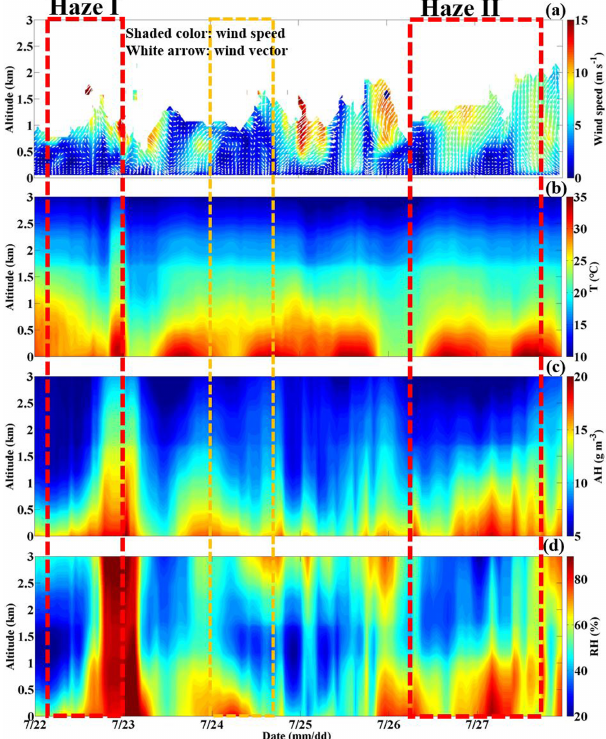
Figure 4. Temporal variation in the vertical profiles of the (a) hori- zontal wind vector (the white arrows denote wind vectors), (b) tem- perature ( T ), (c) absolute humidity (AH) and (d) relative humidity (RH) at the BJ site from 22 to 27 July 2019 (the yellow box repre- sents the light-haze pollution period, and the red box represents the heavy-haze pollution episode).